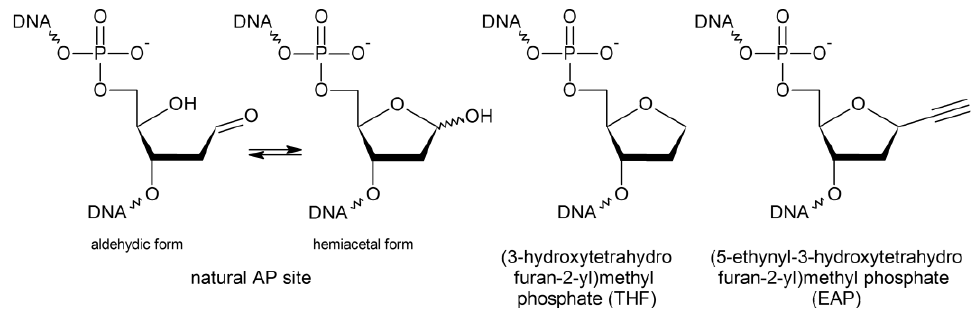
Figure 1. Structures of the natural AP site and its synthetic analogs.